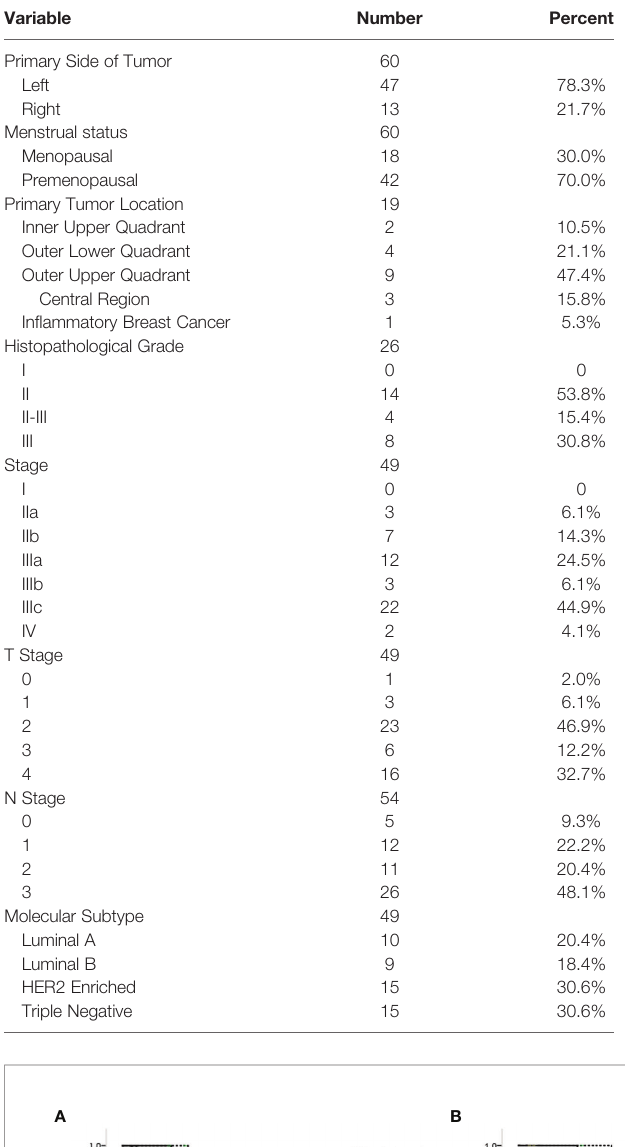
TABLE 1 | Clinical and pathological characteristics of patients at initial diagnosis.